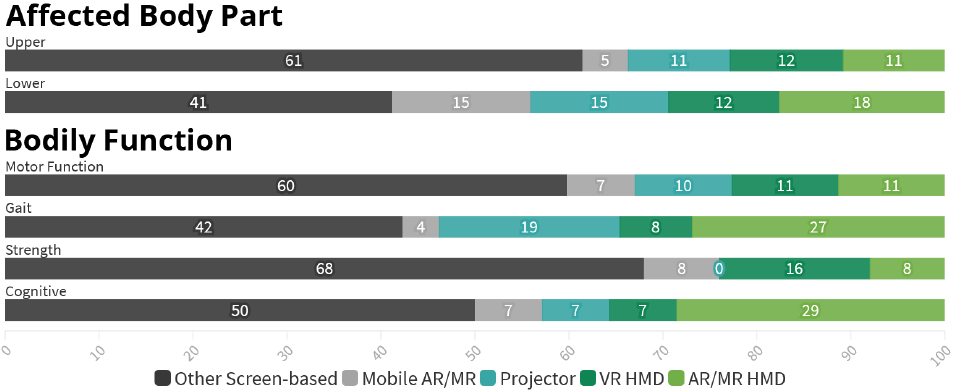
Figure 10. Differences in used Output Technology in relation to Affected Body Part and Bodily Function . Numbers represent